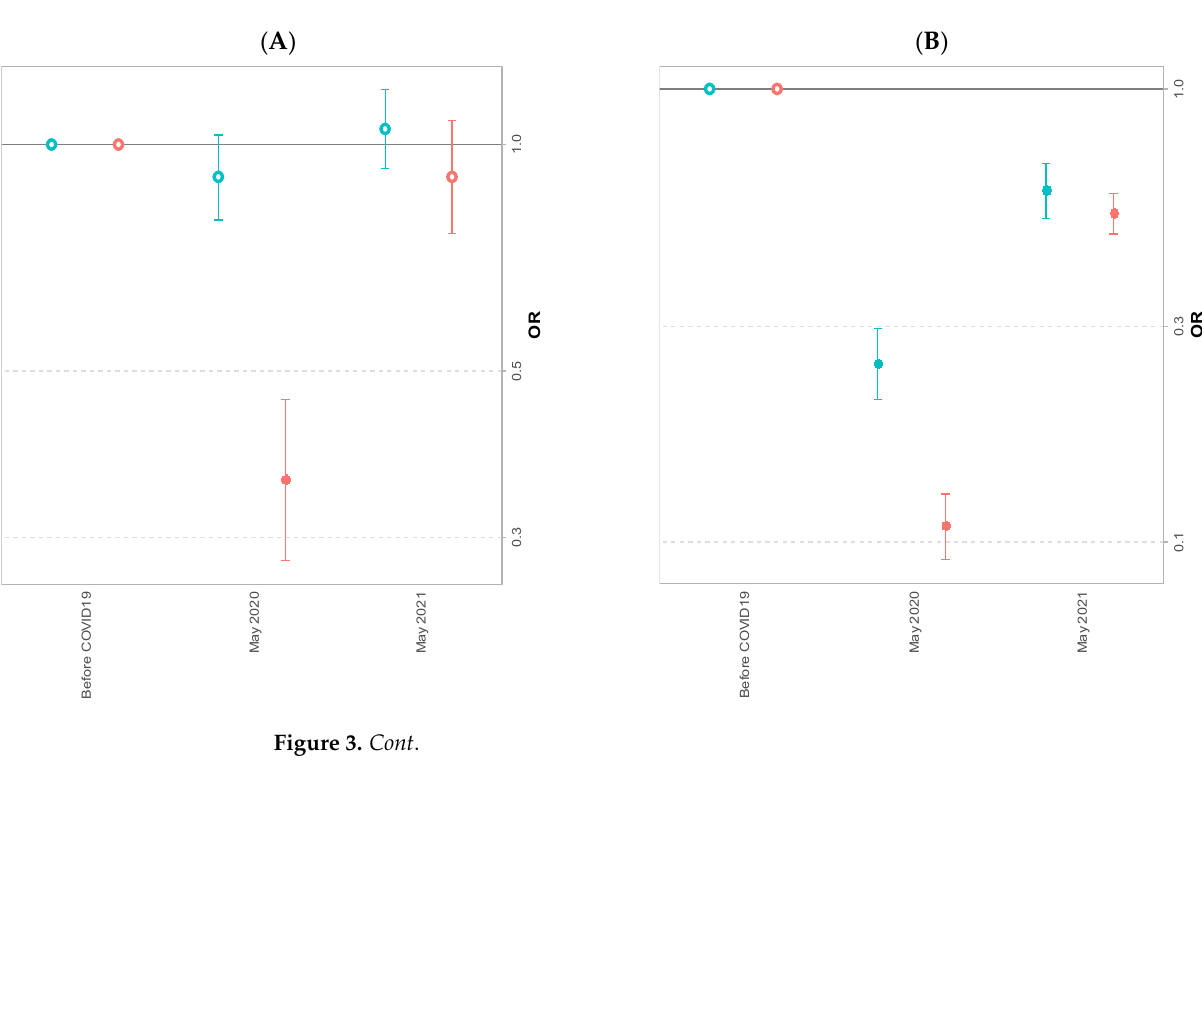
Figure 2. Moderate and vigorous physical activity of university students before COVID-19 pandemic,